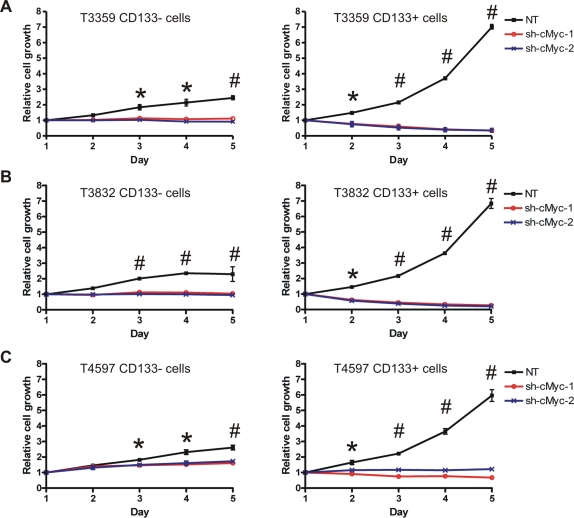
Depletion of c-Myc inhibits growth of glioma cancer stem cells.(A) T3359, (B) T3832, and (C) T4597 CD133− and CD133+ cells were isolated and infected as described. Cells were then plated in 96-well plates in triplicate at 5000 cells per well for CD133− cells or 1000 cells per well for CD133+ cells. Total viable cell numbers were then determined by the CellTiter-Glo Luminescent Cell Viability Assay (Promega) daily. *, p<0.05; #, p<0.001 with one-way ANOVA comparison of the control groups to the corresponding c-Myc knockdown groups on the same day.